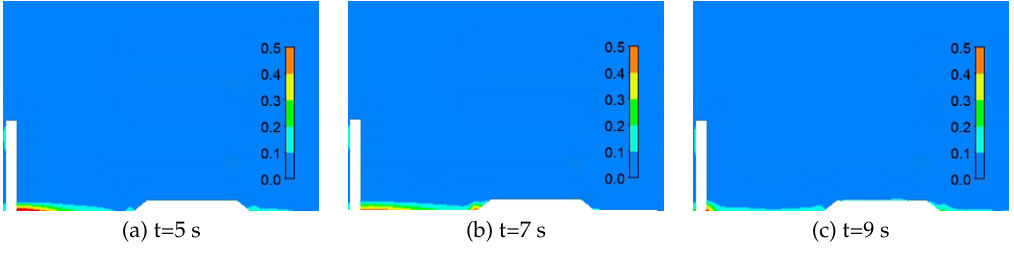
Fig. 20. Contour of sand volume fraction around the embankment at different times under double wind-break